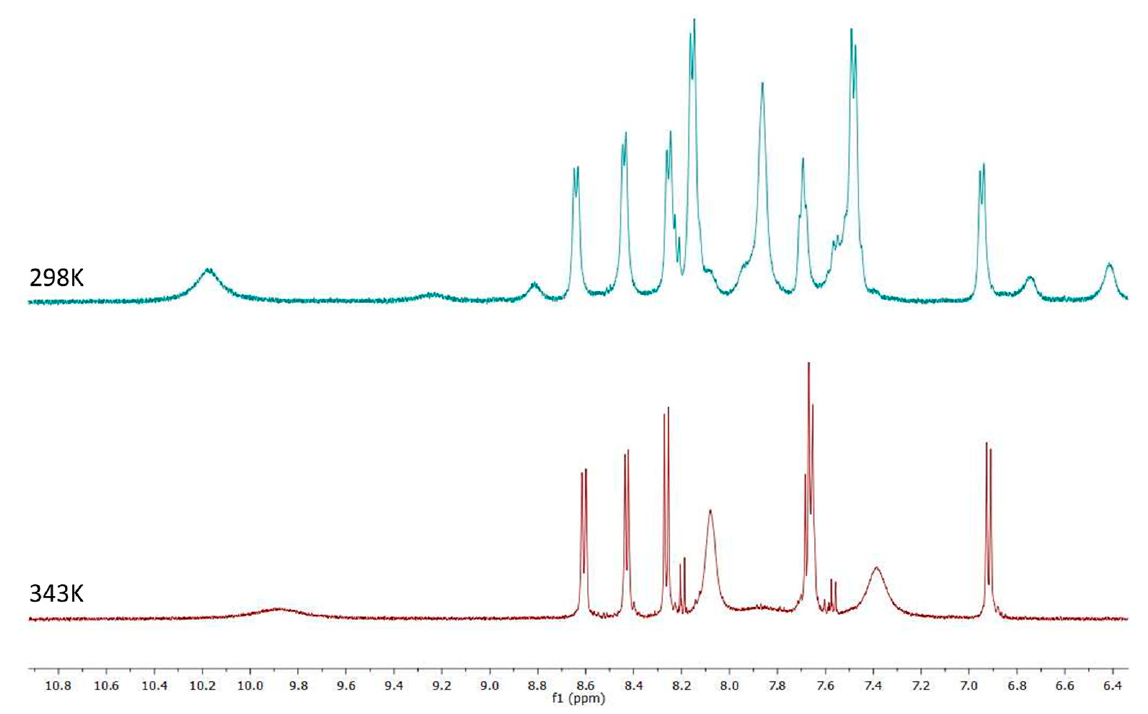
Figure 2. Variable-temperature 1 H NMR experiments of SN1 at different temperatures in DMSO-d 6 (10 − 3 M).